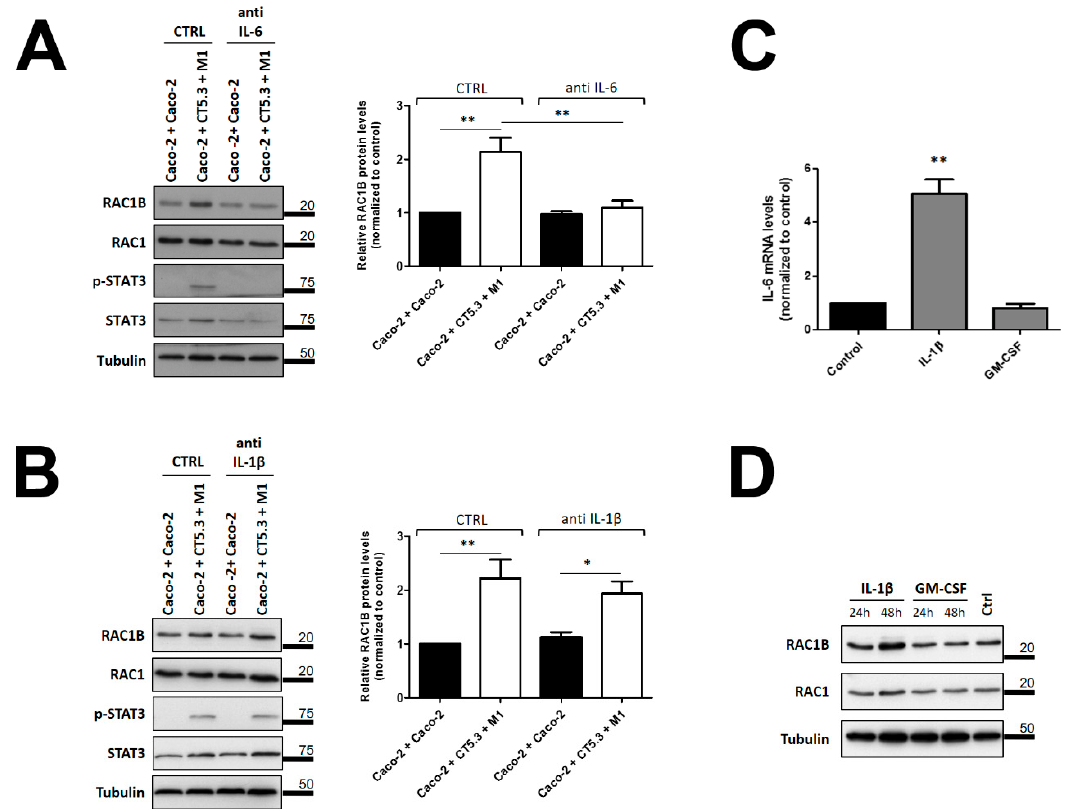
Figure 6. Effect of neutralizing antibodies against IL-6 or IL-1 β on phospho-STAT3 and RAC1B protein levels in Caco-2 cells. Polarized Caco-2 cells were co-cultured with the indicated control or with CT5.3 and M1 macrophages, in the presence of 500 ng/mL of neutralizing antibody against ( A ) human-IL-6 or ( B ) human IL-1 β . Cells were lysed after 48 h of culture, proteins from the whole-cell lysates analysed by SDS-PAGE and the indicated proteins detected by WB. Detection of the tubulin protein served as a loading control and migration position of molecular weight markers is indicated in kDa. The control of the assay corresponds to the co-culture of Caco-2 with Caco-2 cells in the presence of antibody solvent (PBS). Graphics show the fold change in RAC1B protein relative to the control co-culture and represent mean values ± SEM of at least 3 independent experiments. Statistical analysis was carried out with a one-way ANOVA test (( A ): F = 13.21, p < 0.001; ( B ): F = 9.15, p < 0.001), followed by Tukey’s post hoc tests; * or ** significantly different from the corresponding control condition (Caco-2 + Caco-2 or PBS) with p < 0.05 or p < 0.01, respectively. ( C , D ) Effect of purified IL-1 β on ( C ) endogenous IL-6 mRNA expression and ( D ) RAC1B protein in Caco-2 cells. Polarized Caco-2 cells were incubated in the presence of 10 ng/mL of indicated purified cytokines. The control of the assay corresponds to Caco-2 cells incubated with antibody solvent (PBS). In ( C ), the endogenous IL-6 transcript levels in Caco-2 cells are shown after 24 h, as determined by qRT-PCR. Data are shown as fold change relative to control and represent mean values ± SEM, of at least 3 independent experiments. Statistical analysis was carried out with a one-way ANOVA test [F = 79.69, p < 0.001], followed by Tukey’s post hoc tests; ** significantly different from the corresponding control with p < 0.01. In ( D ), the corresponding IL-1 β effect on RAC1B and control protein levels after 24 and 48 h are shown in whole-cell lysates by